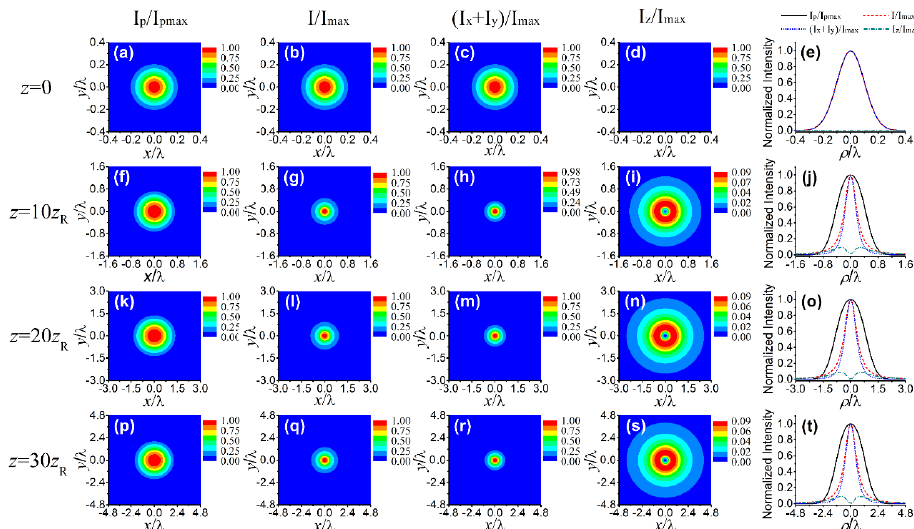
beam. Second column: the total intensity I for the nonparaxial SCRP beam. Third column: the transverse intensity I x + I y for the nonparaxial SCRP beam. Fourth column: the longitudinal intensity I z for the nonparaxial SCRP beam. Fifth column: the corresponding cross lines   y x  with =   , and the intensities are normalized with respect to their . Here, the beam width 0 maxima.